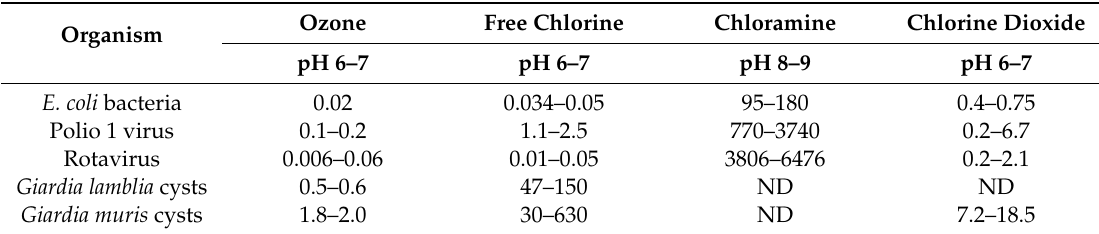
Table 8. Comparison of CT values in mg-min / L for various oxidants to achieve 2-log (99%) inactivation of the given organism at 5 ◦ C, as noted by Ho ff , USEPA, 1986. ND = not determined. [177].